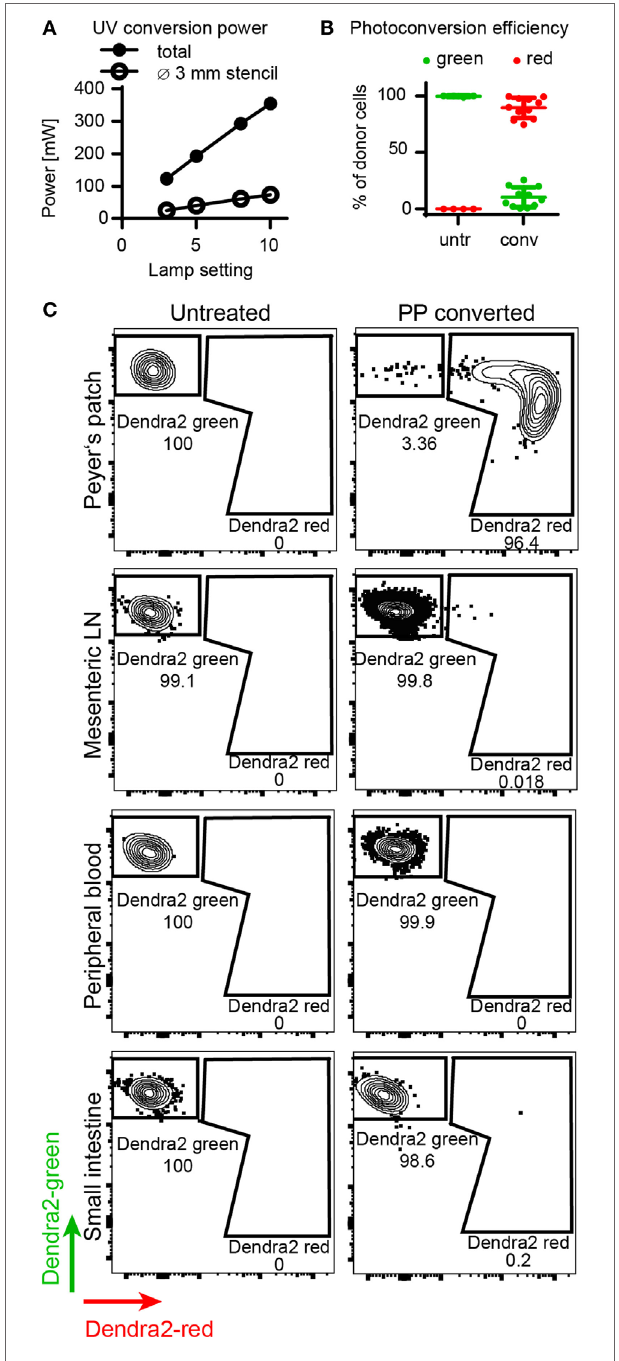
FIGUrE 2 | Efficiency of Dendra2 + donor cell photoconversion in the Peyer’s patches. (A) Output power of LED lamp as measured by power meter. The plot shows total output (without stencil) and applied power on Peyer’s patch (with stencil). (b) Photoconversion efficiency of donor T cells in the Peyer’s patch. Before photoconversion, 0% of the cells contained red protein, after photoconversion, 89% (mean) of the cells were red. (c) Representative FACS plots of donor cells isolated from the Peyer’s patches, mesenteric lymph nodes, peripheral blood, and the small intestine before and right after photoconversion. Peyer’s patches contain a clear photoconverted population after photoconversion, whereas all other organs contain unconverted cells at this time